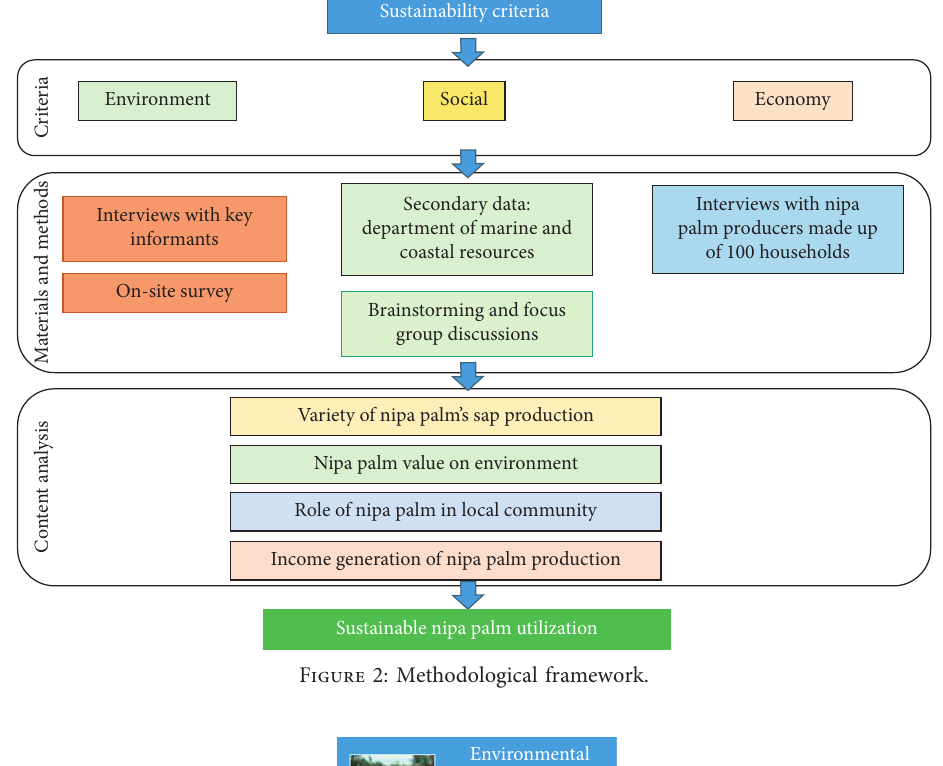
Figure 2: Methodological framework.